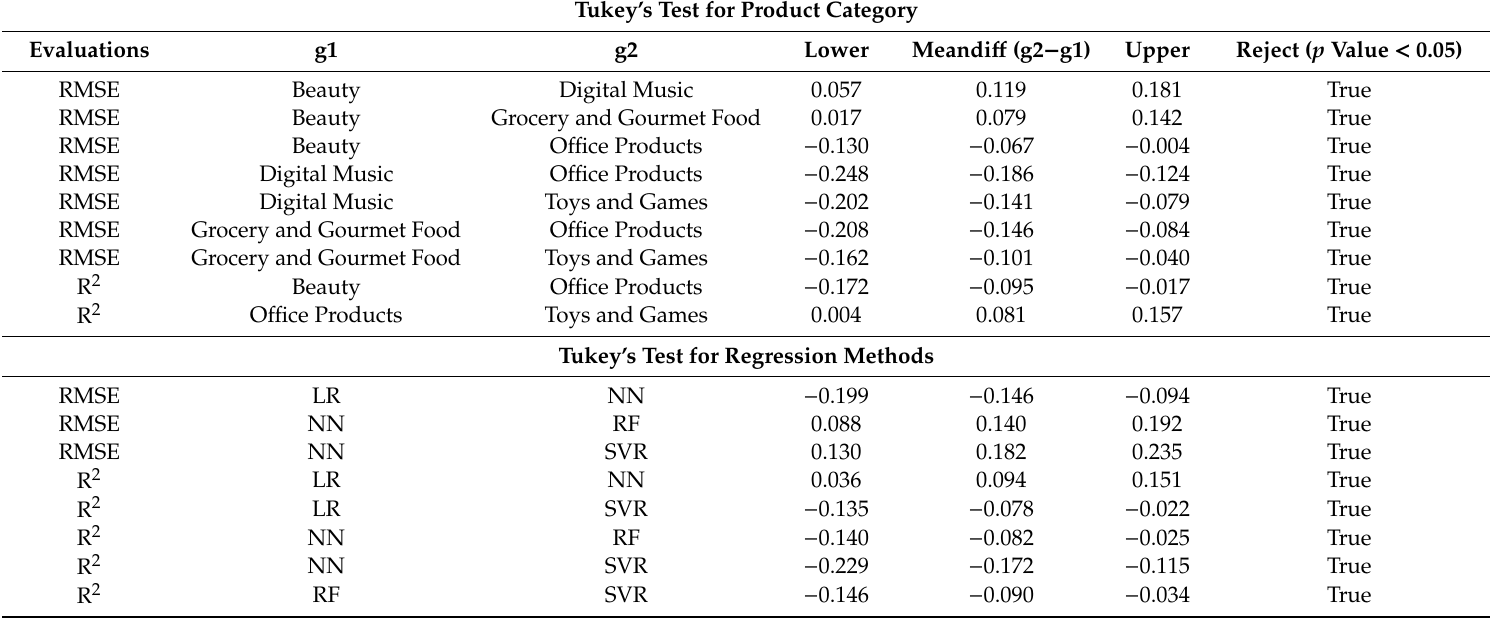
Table 10. Tukey’s range test for product category and regression